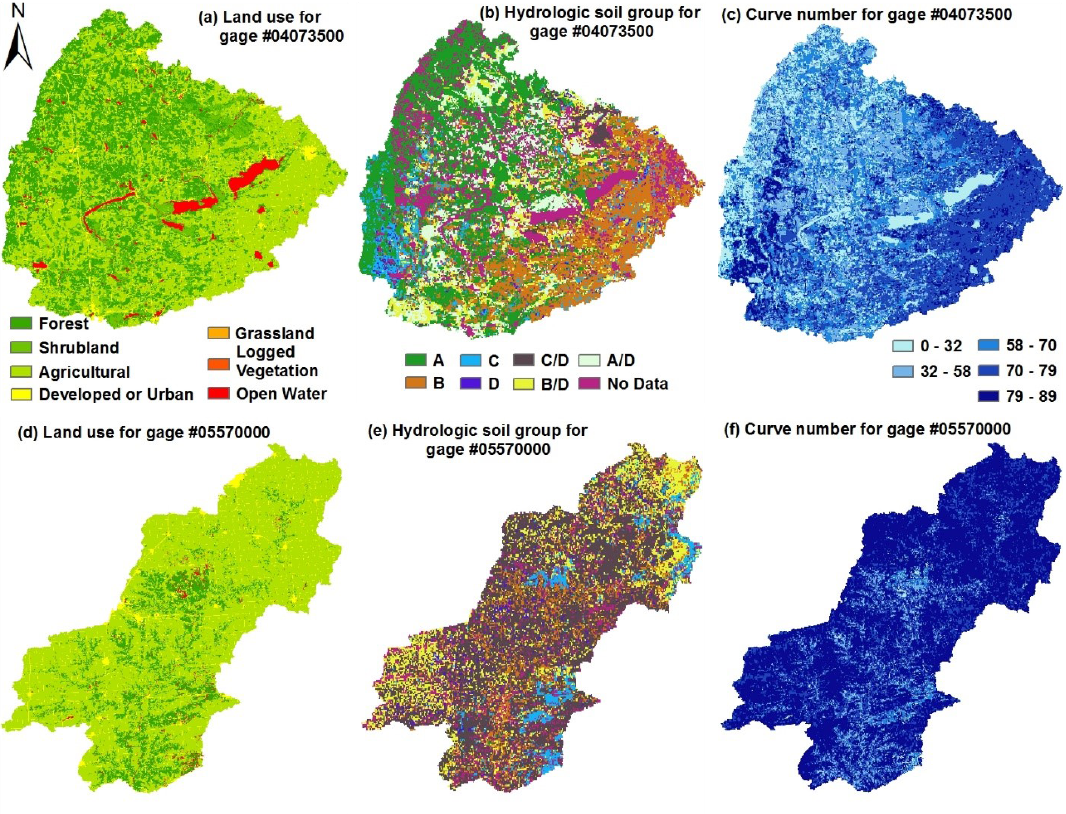
Figure 3. The spatial distribution of land use and land cover for the Fox River watershed in Wisconsin (a) and the Spoon River watershed in Illinois (d) , the hydrologic soil groups for Fox River watershed (b) and Spoon River watershed (e) , and the curve numbers for Fox River watershed (c) and Spoon River watershed (f)